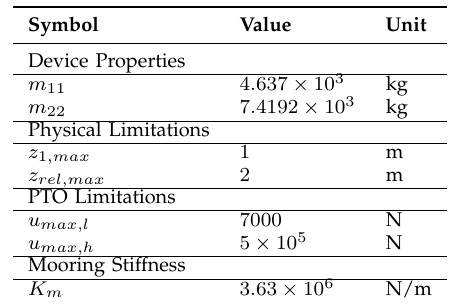
TABLE I: The data applied in the simulation of the proposed